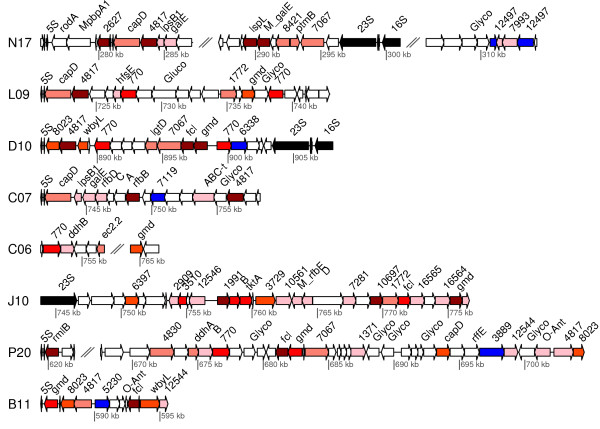
Gene order structures of hypervariable segments. SAG contigs with homologs to genes located in the hypervariable region HVR2 in the marine SAR11 genomes, as identified by BLAST search (E < e-10). The intensity of the red color indicates the number of SAR11 genomes for which a homolog was identified in HVR2 (pink = 1; dark red = 5). Blue color indicates glycosyltransferases identified as gained in LD12. Cluster annotations are shown, with cluster numbers used for clusters with no annotated gene name.